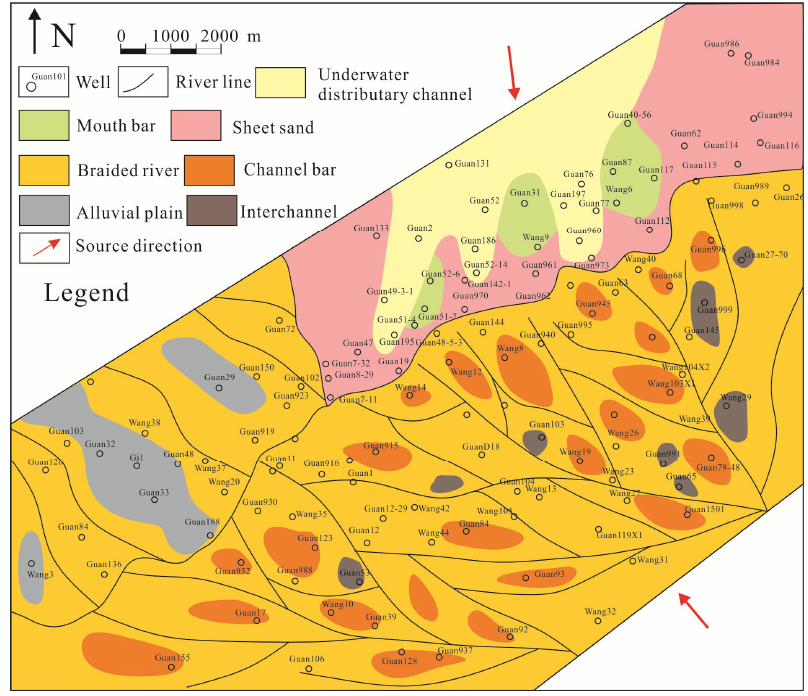
Figure 5. Sedimentary facies map in ZV of the Wang guantun area.